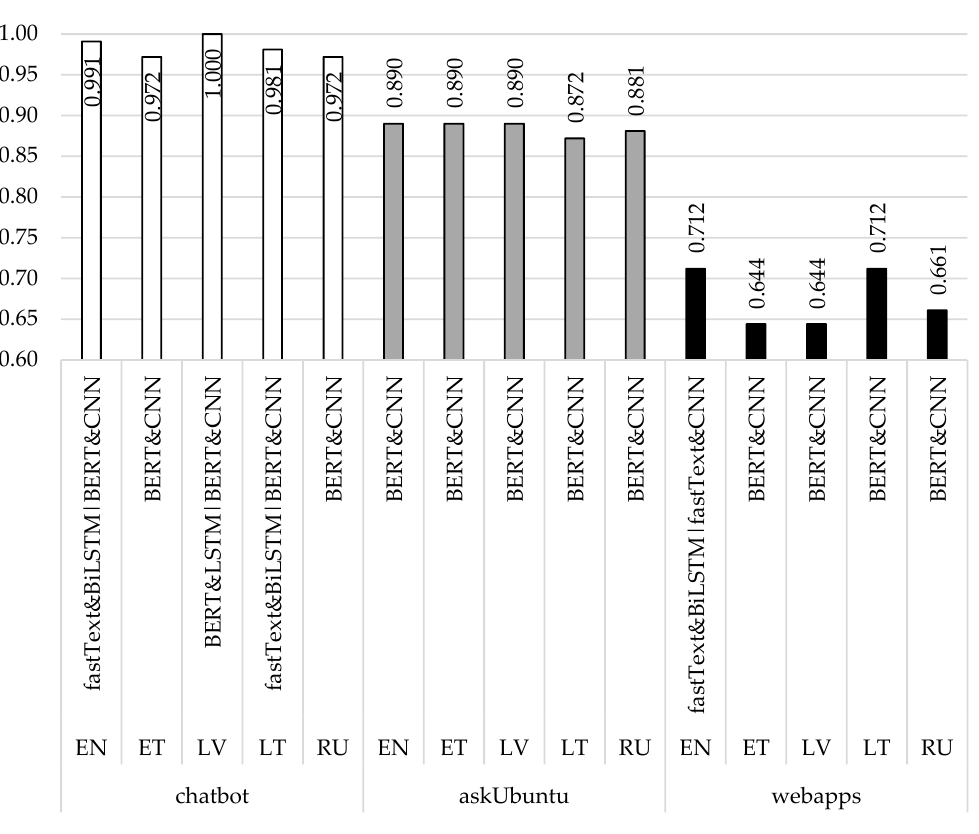
Figure 2. The best results achieved on di ff erent datasets with di ff erent